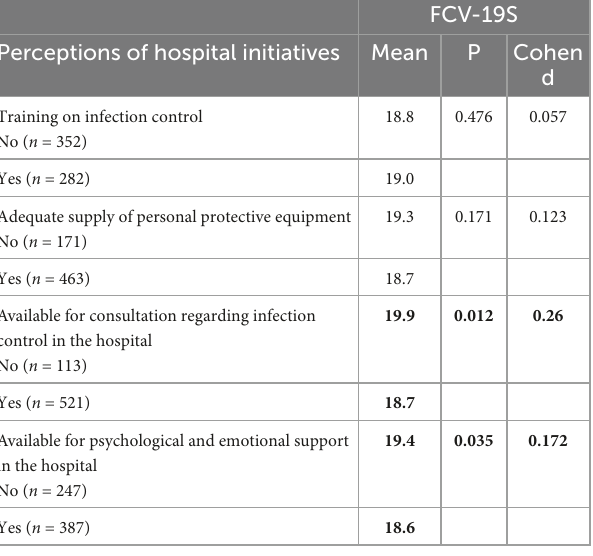
TABLE 4 The associations between FCV-19S and perceptions of hospital